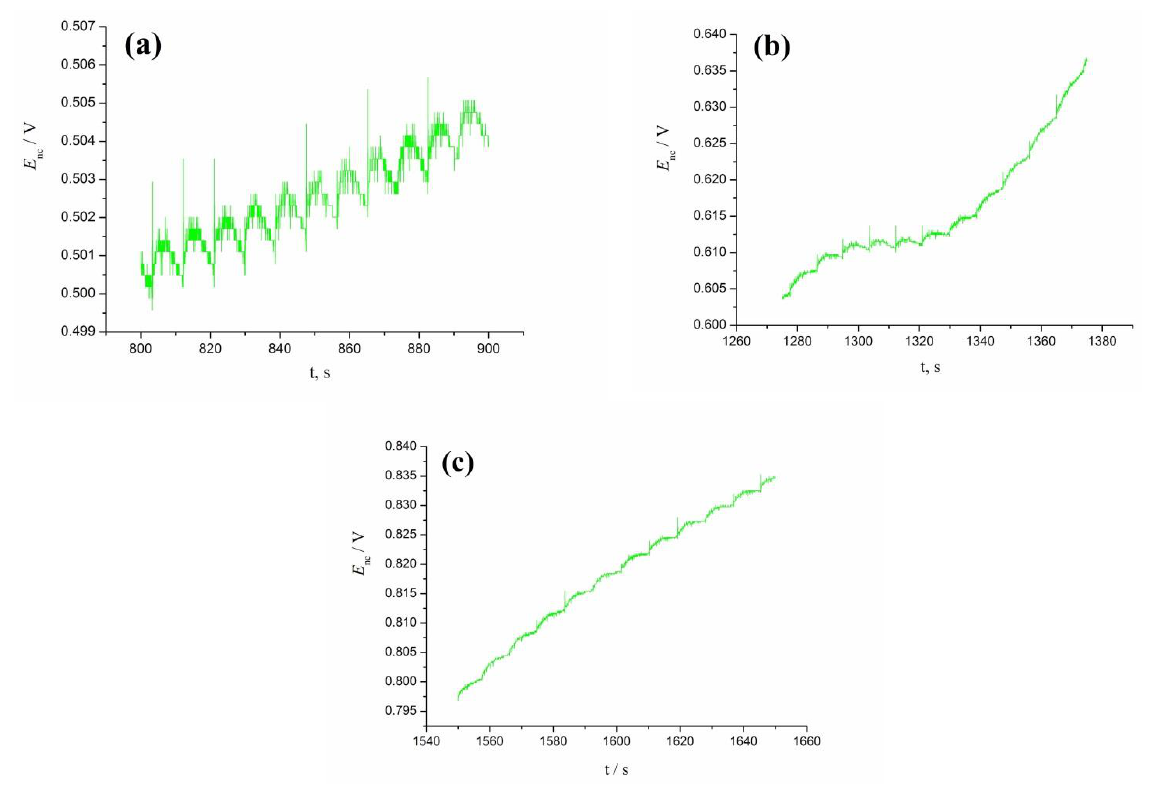
Figure 10. ( a – c ) Different parts of the transient of the non-current potential, which was recorded from the starting value 0.08 V on Figure 8a.